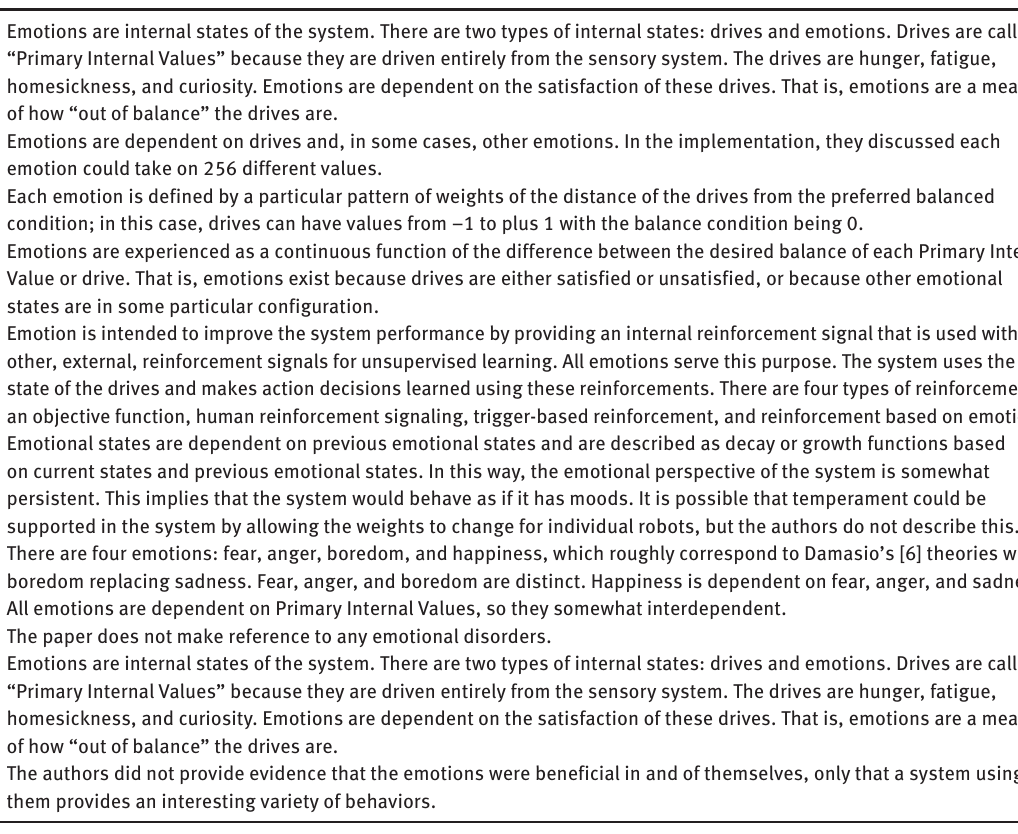
Table 7. Classification of EMOBOT